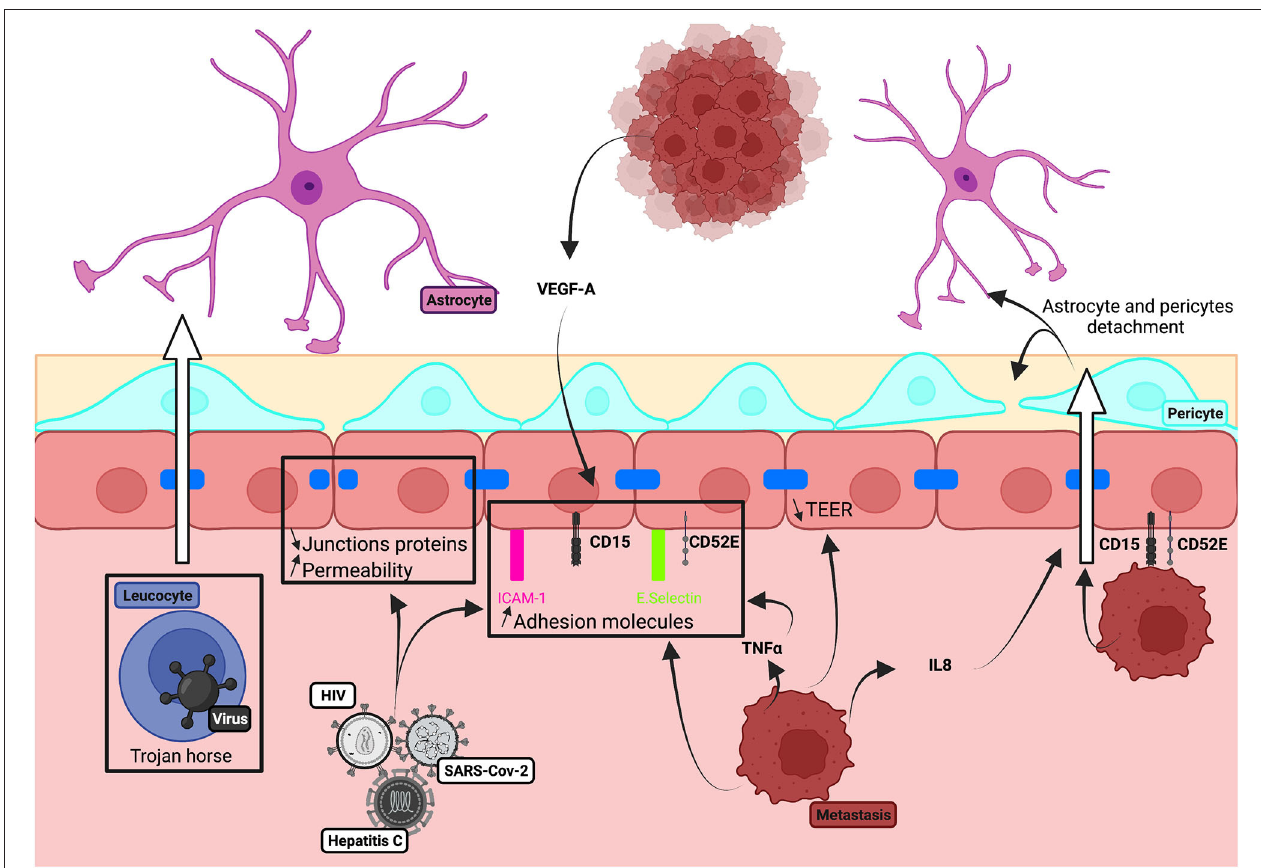
FIGURE 5 | Schematic illustration of brain invasion on in vitro human BBB